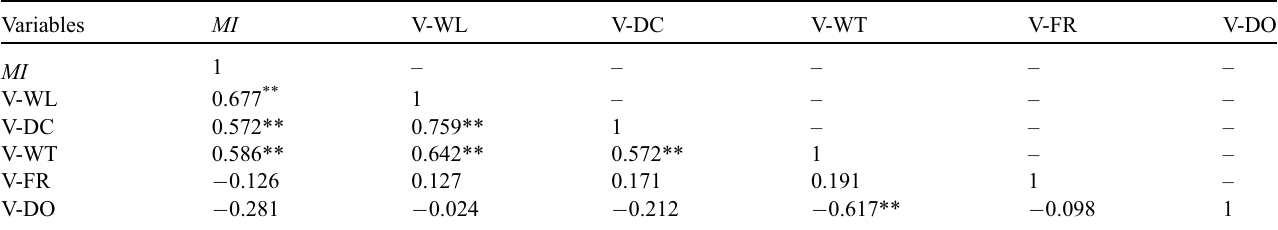
Table 2. Pearson correlation analysis for MI and the variations of environmental factors.